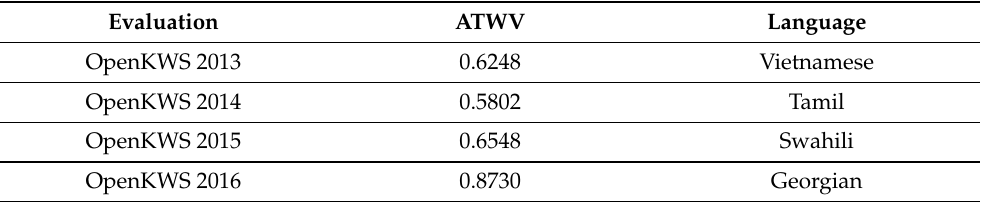
Table 6. Best performance (in terms of the Actual Term Weighted Value, ATWV) obtained in the different editions (2013, 2014, 2015 and 2016) of the OpenKWS evaluations under the full language pack condition. Evaluation